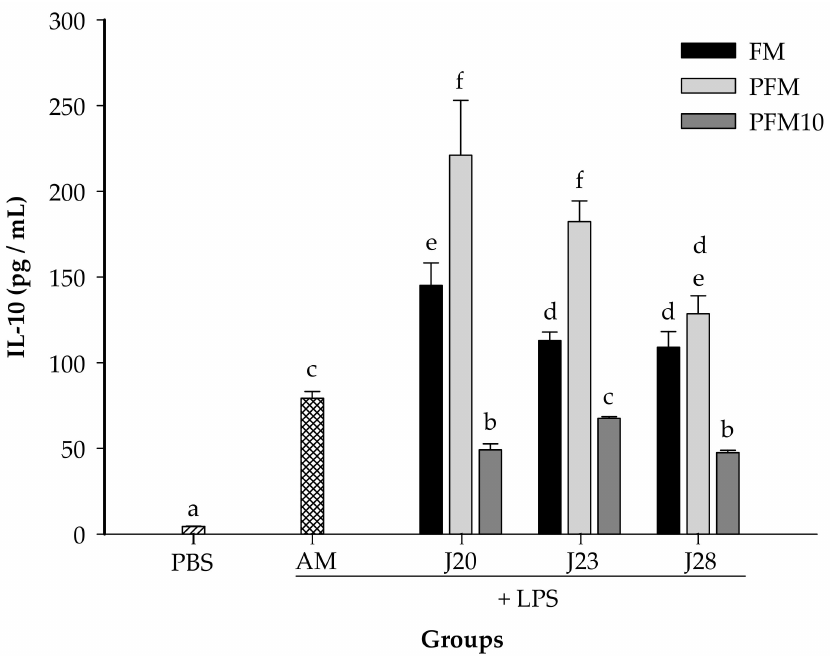
Figure 6. Serum concentration of IL-10. Groups were daily administrated for 4 weeks with fermented milk (FM), pasteurized fermented milk (PFM), fractions <10 kDa of PFM (PFM10) with Lactobacillus J20, J23 or J28; after 4 weeks, rats were injected with LPS, and sacrificed after 6 h post-injection. Control groups included: acidified milk (AM) injected with LPS; or phosphate buffer saline (PBS) without LPS. Bars represent means ± SE ( n = 6). Different letters indicate significant differences ( p < 0.05) among all